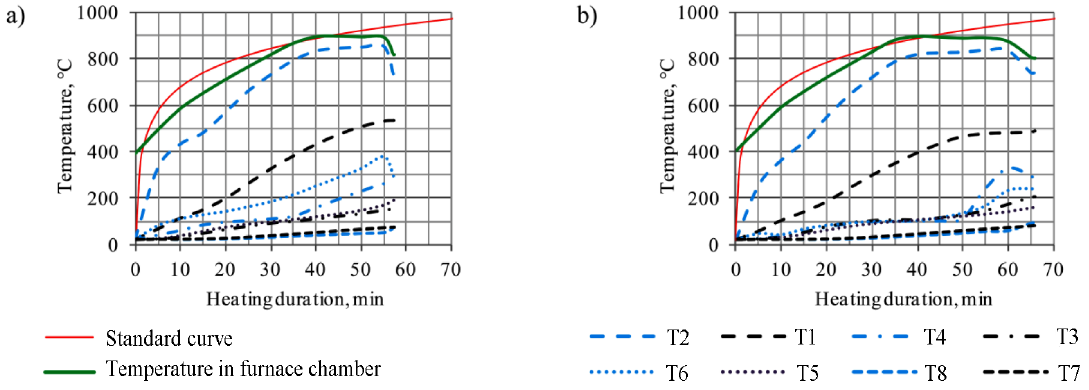
Fig. 4. Variation of temperature in the furnace and at different thermocouples locations (T1–T8, see Fig. 3) with time: a) beam 1, b) beam